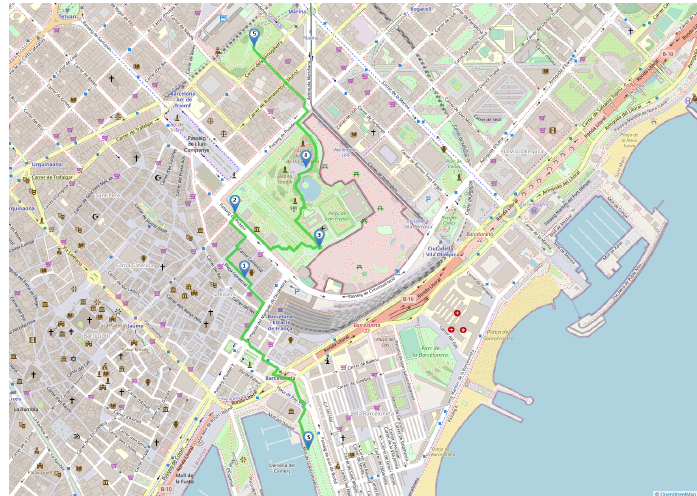
Figure 2. Conscious Walk Route Design.